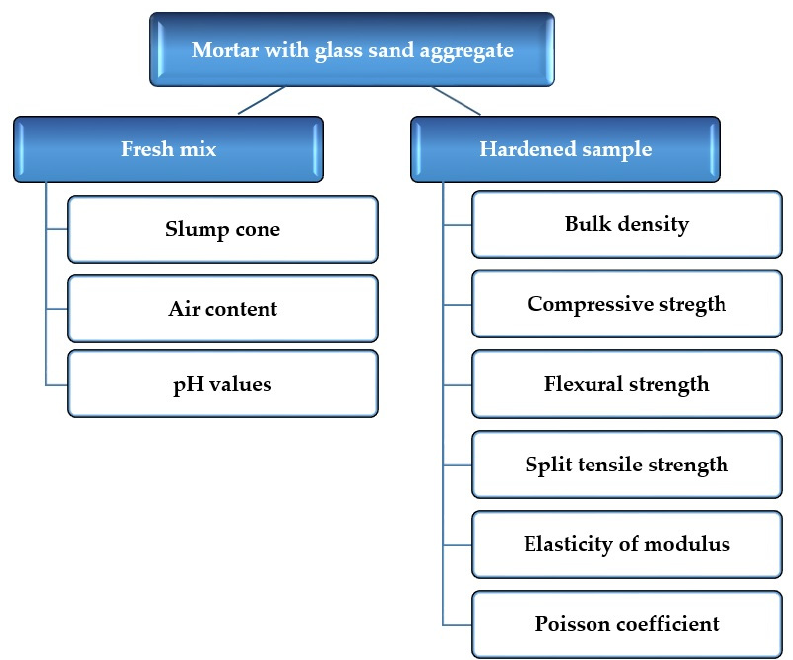
Figure 3. Schema diagram of properties determined in tests.